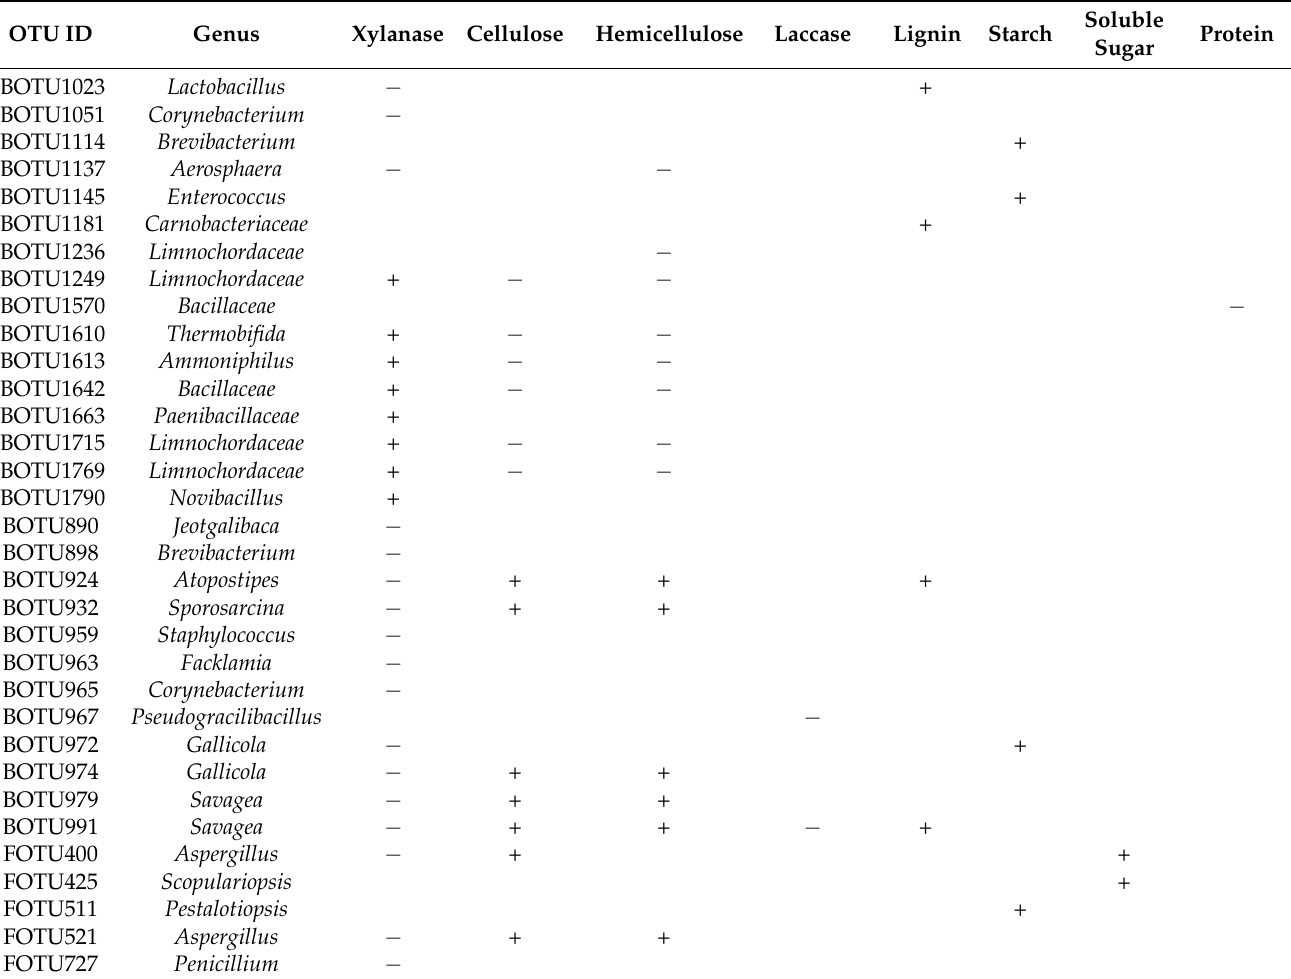
Table 1. The OTUs directly interact to the enzymes and carbon sources in the